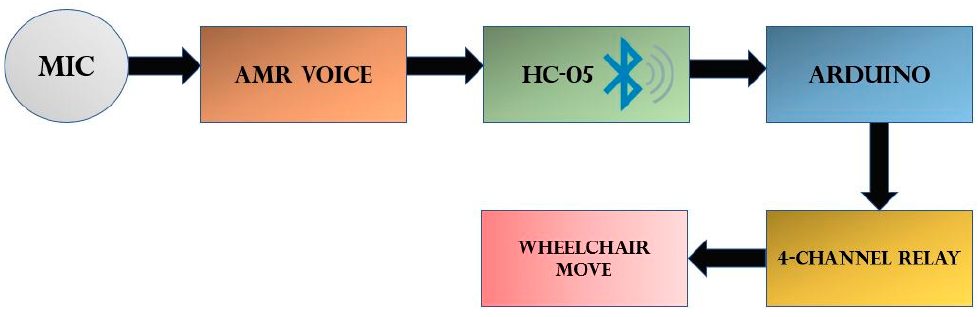
Figure 7. Block diagram for voice control mode.